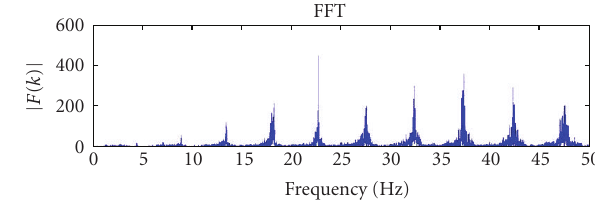
Figure 11: Frequency spectrum of the vibration of a hanger.